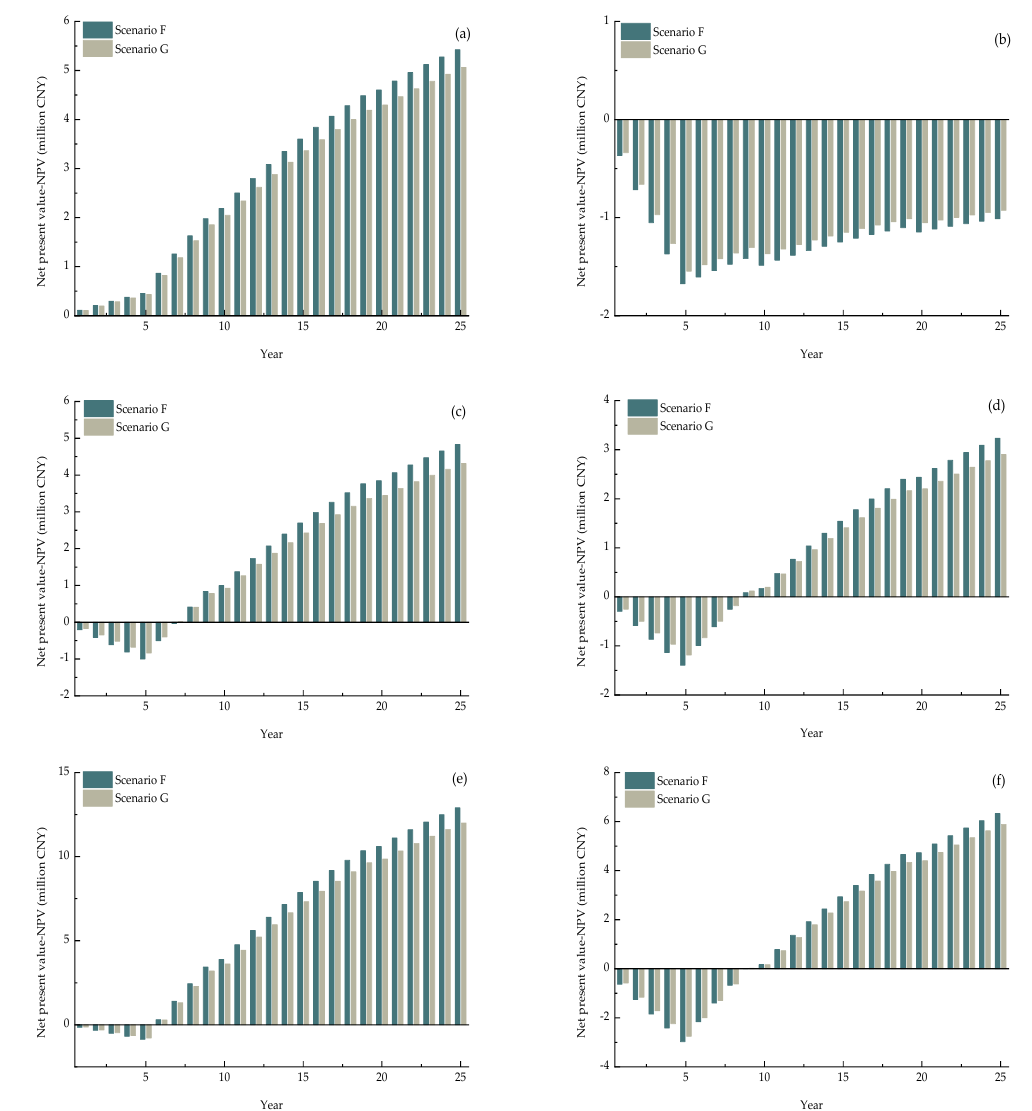
Figure 13. Net present value of PV systems on the pitched rooftops in the three studied universities under two scenarios: ( a ) “full -self- consumption” mode in Tibet University; ( b ) “full -feed-into- grid” mode in Tibet University; ( c ) “full -self- consumption” mode in Qinghai University; ( d ) “full -feed-into- grid” mode in Qinghai University; ( e ) “full -self- consumption” mode in Qilu University of Technology; ( f ) “full -feed-into- grid” mode in Qilu University of Technology.